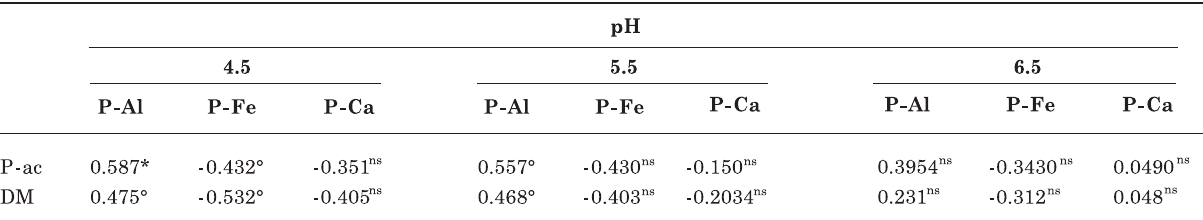
ns , ° ,* and **: non-significant and significant at 10 and 5 %, respectively.